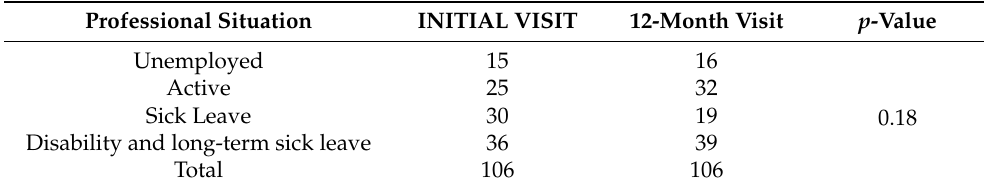
Table 5. Contingency table presenting professional situation evolution between the initial visit and the 12-month visit of the PREDIBACK study for patients of working age and normally active.